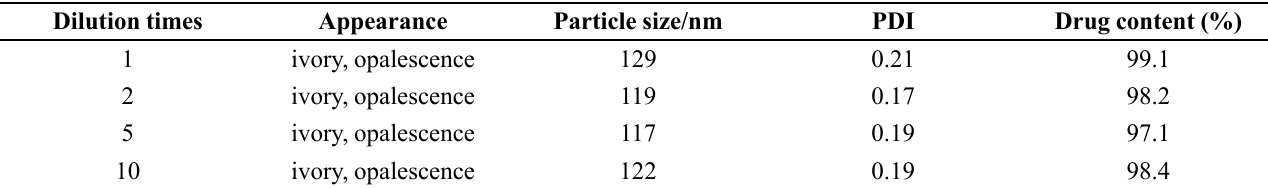
TABLE III - The results of stability experiments (n=3) Dilution